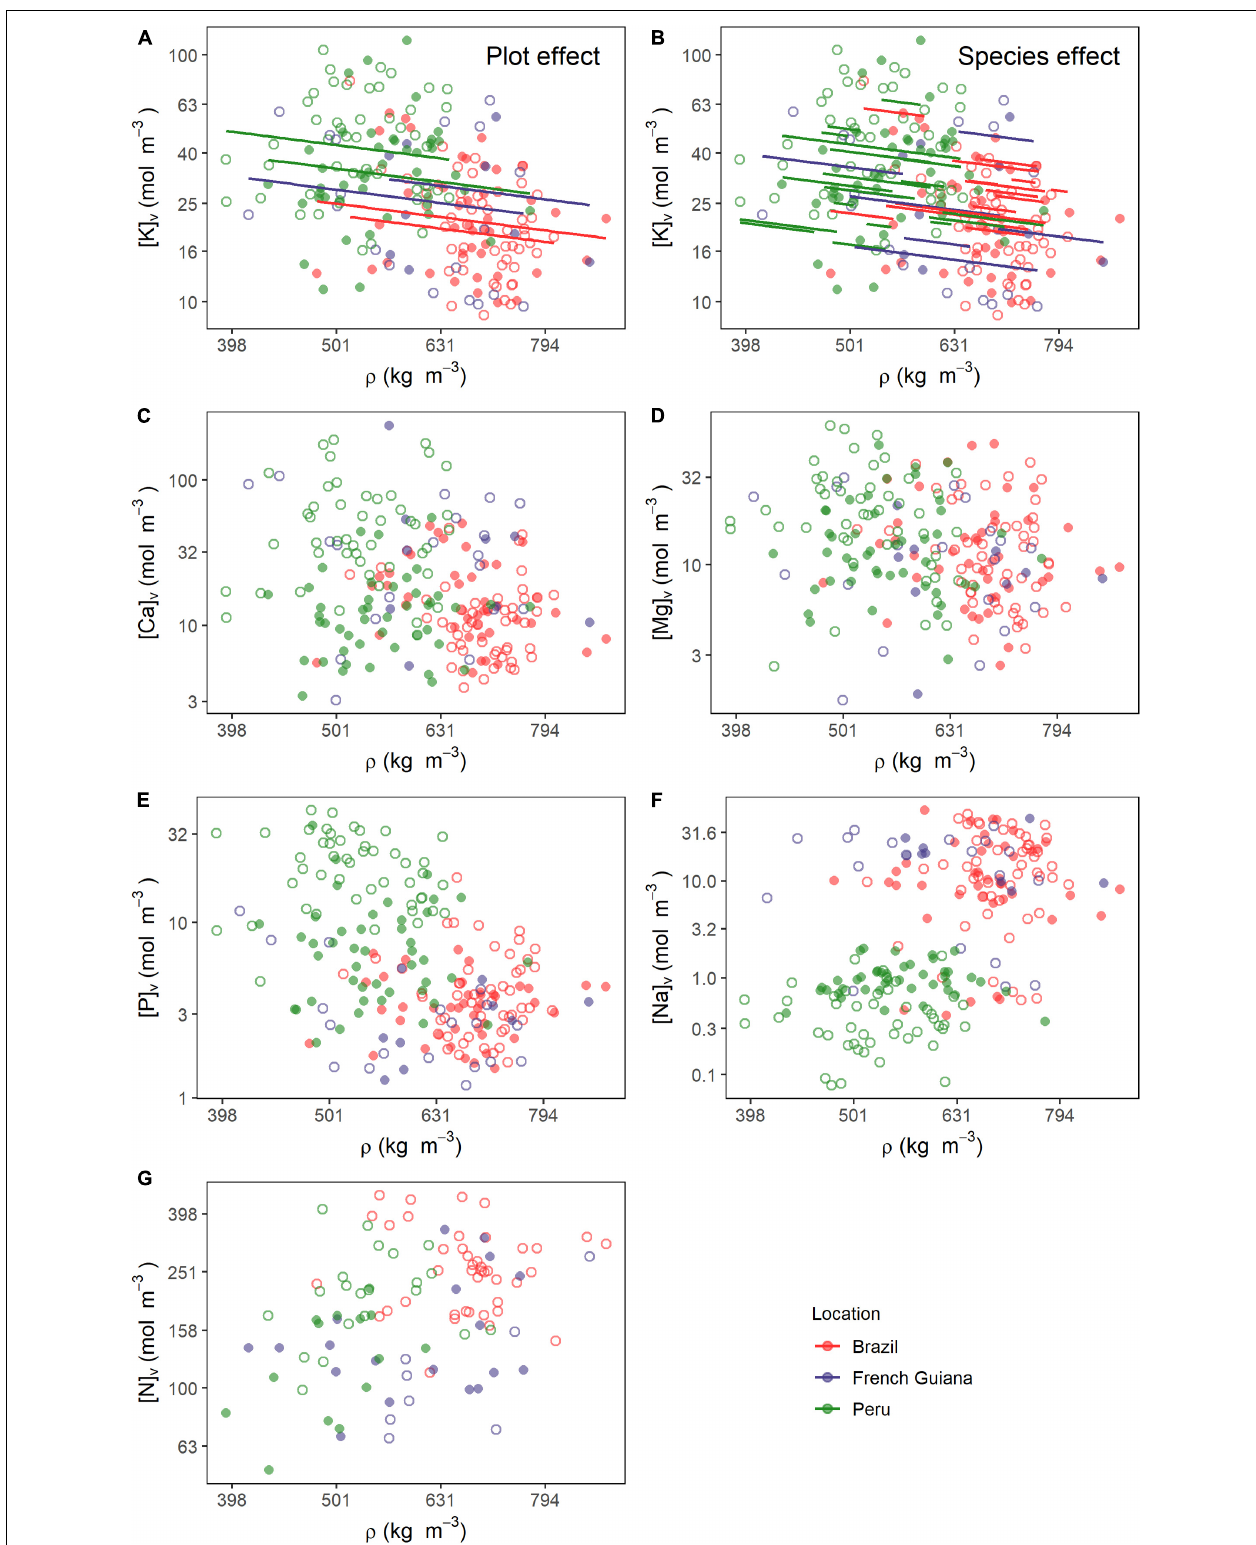
FIGURE 4 | Relationships between wood density ( ρ ) and nutrients on a volume basis ( (cid:50) v ). Lines in (A) and (B) are predicted estimates of mixed models for the species and plot effects (Equation 6) for the relationship between ρ and potassium. Relationships of ρ with (C) calcium, (D) magnesium, (E) phosphorus, (F) sodium, and (G) nitrogen. All variables were log10 transformed prior to analysis. Open and closed circles represent the plots within each location.